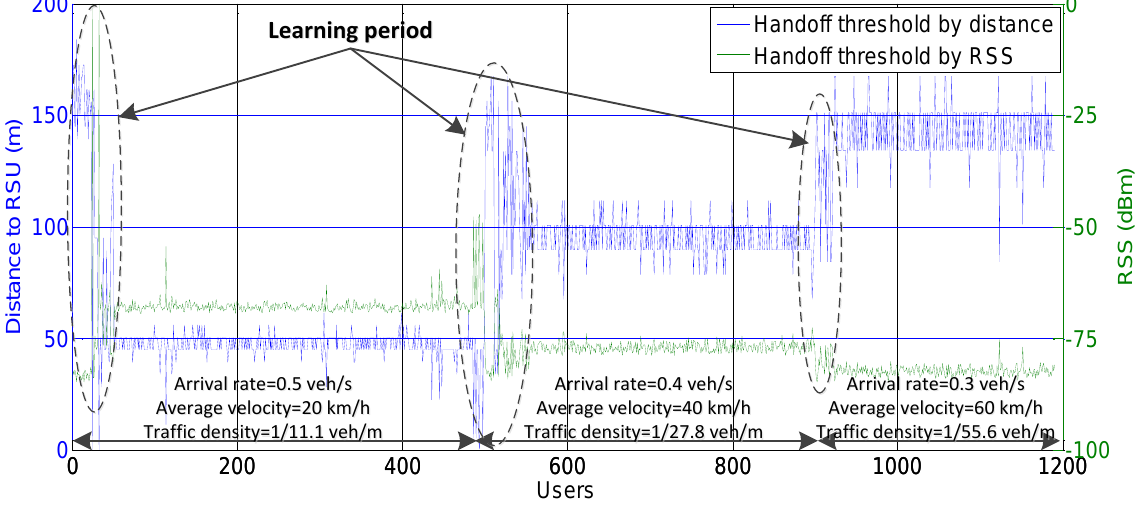
Figure 5. Quantity of users associated with RSU vs. different traffic